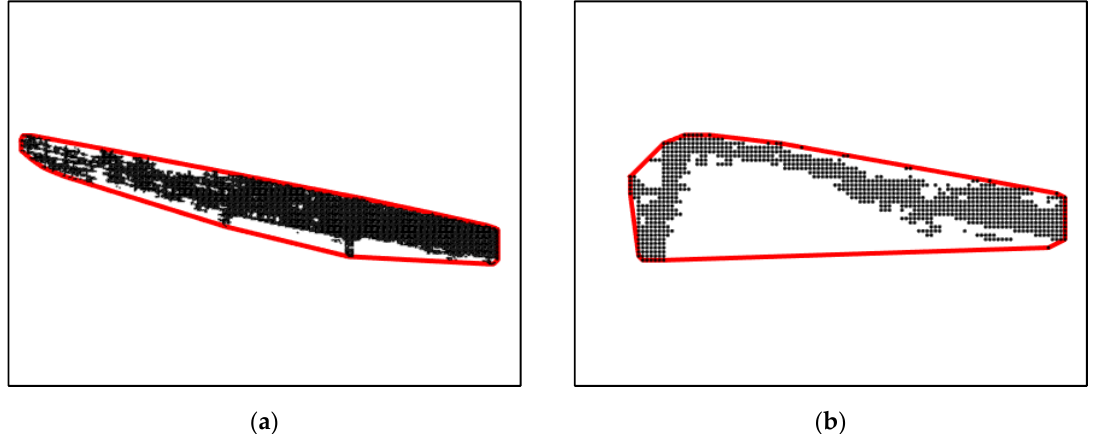
Figure 5. Complexity of data boundaries based on convex hull: ( a ) a cluster that is a thermal bridge and ( b ) a cluster that is not a thermal bridge.